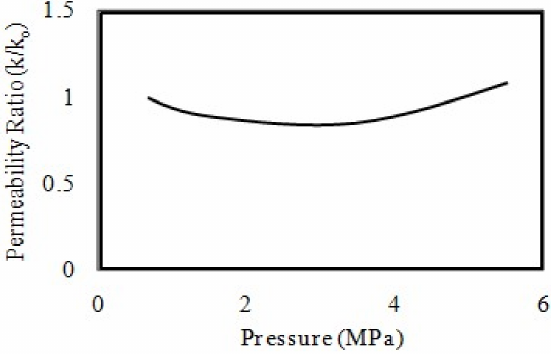
Figure 8. Variation of coal permeability with pore pressure